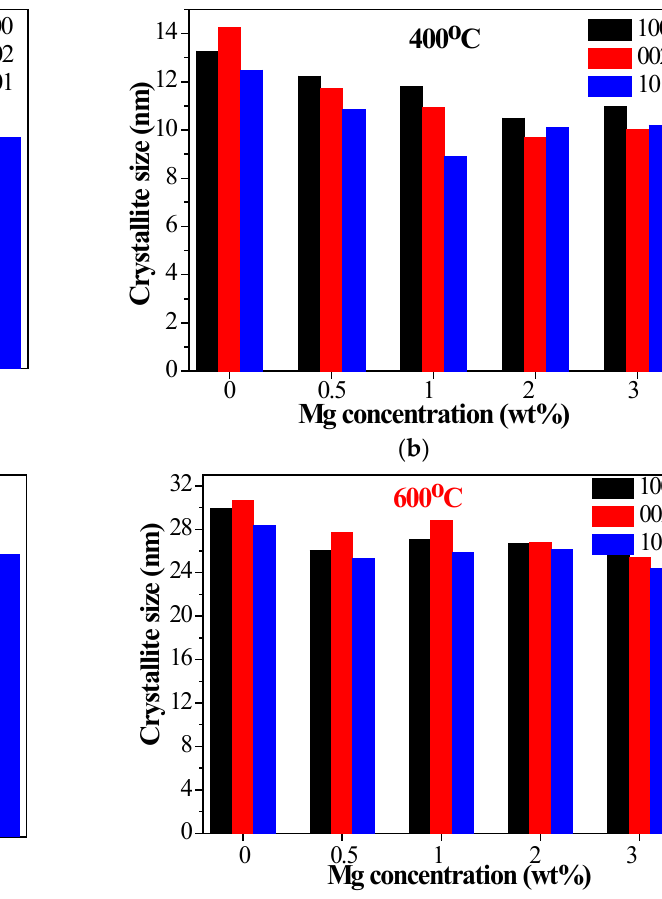
Figure 4. Crystallite sizes along (100), (002), (101) diffraction planes of ZnO and ZnO:Mg films, annealed at ( a ) 300, ( b ) 400, ( c ) 500 and ( d ) 600 °C. The texture coefficient of a plane illustrates the texture of a particular plane and deviation from the standard sample implies the preferred growth. The texture coefficient ( TC ( hkl )) can be calculated from XRD patterns using [46]: